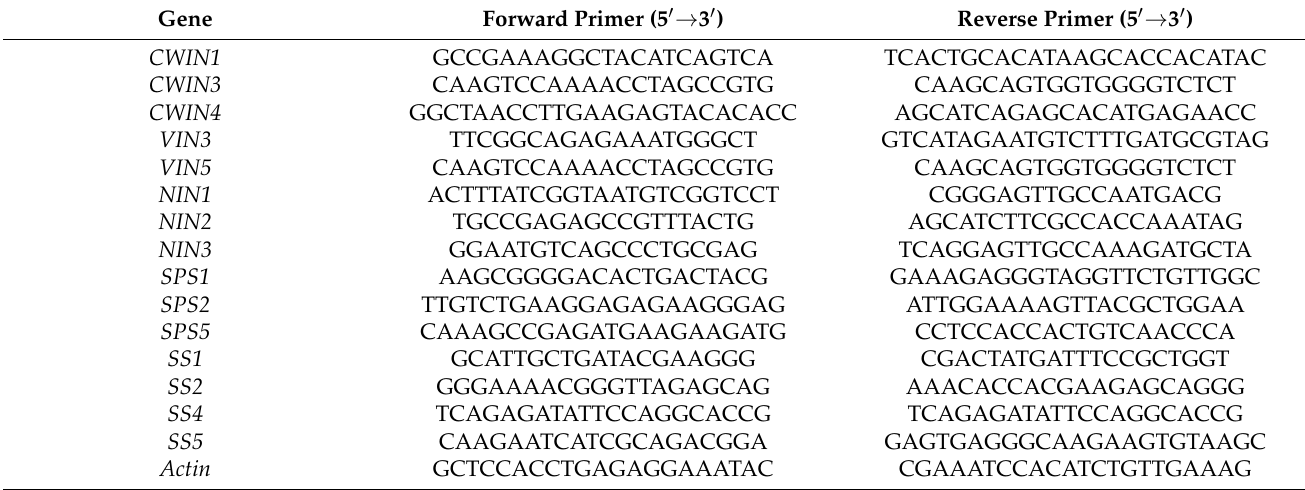
Table 1. Primers used for quantitative real-time